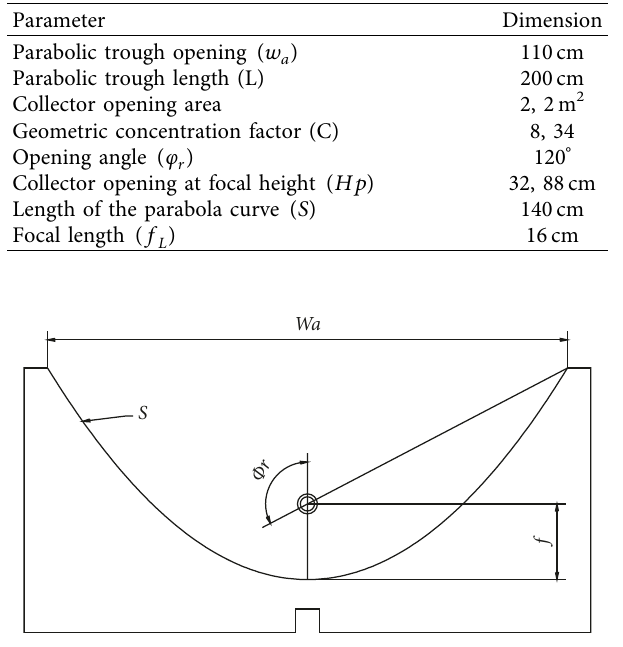
Figure 2: PTSC geometric parameters (see Table 1).